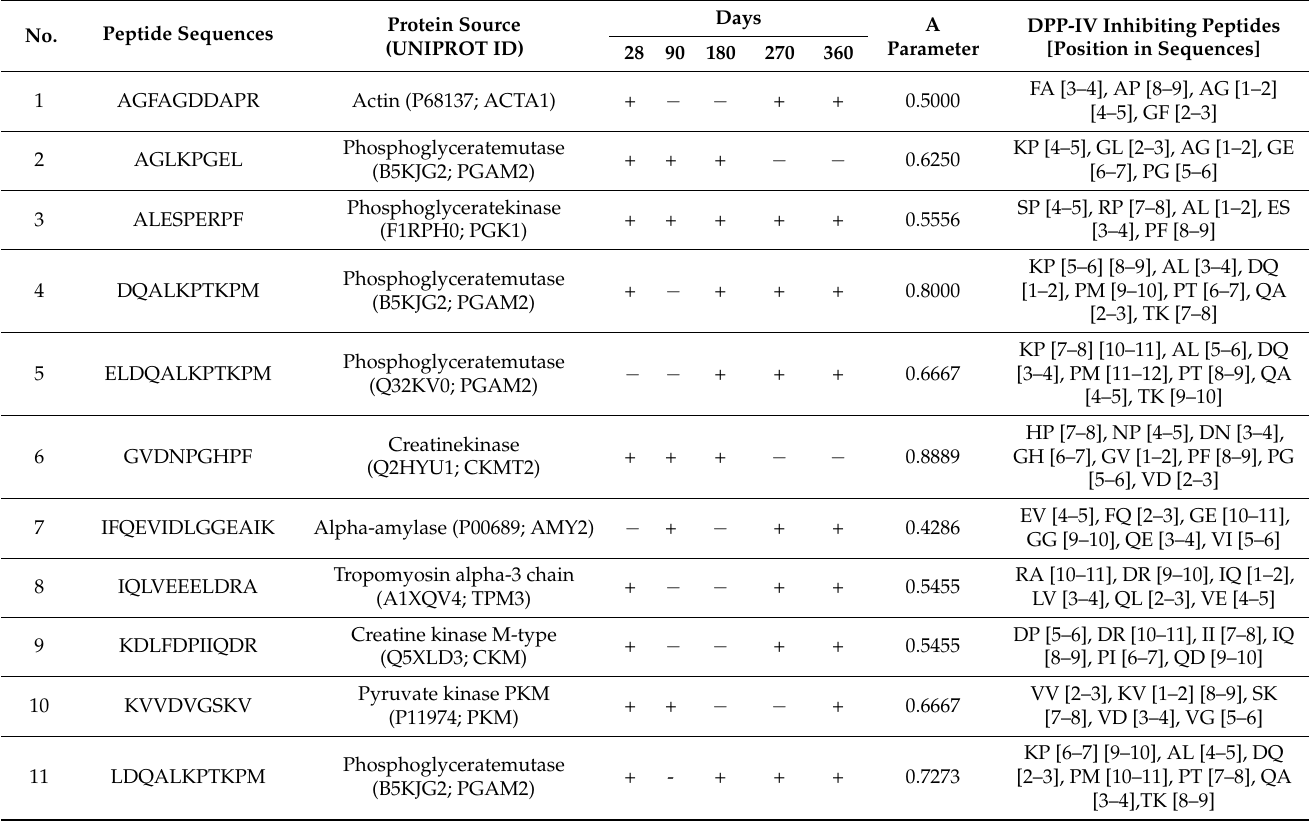
Table 1. Peptide sequences obtained from WSF during 12 months of aging of dry-cured pork loins.